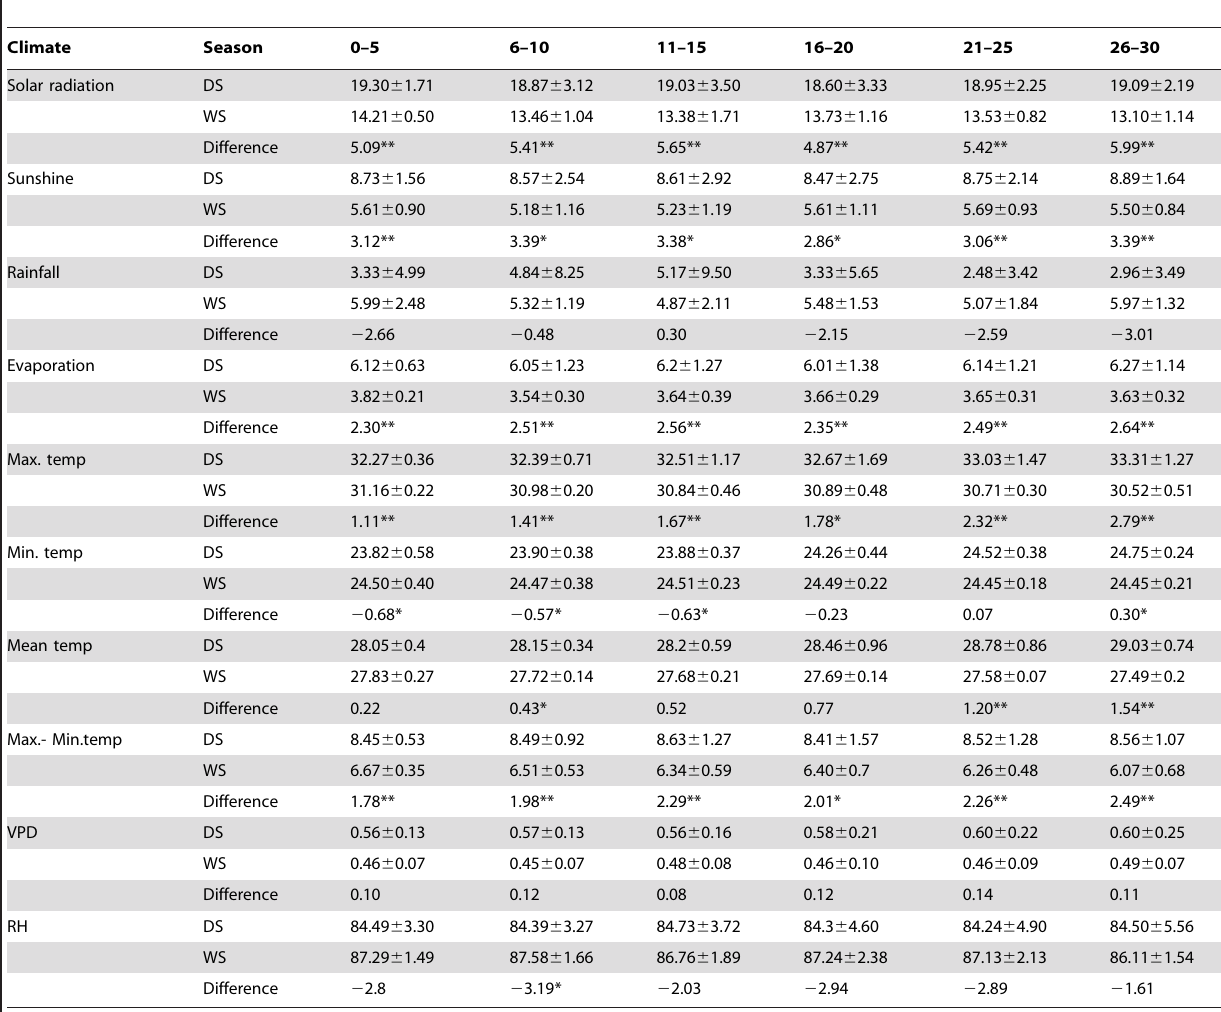
Table 2. 5-day average of climatic data over 39 varieties in DS and WS during grain filling.